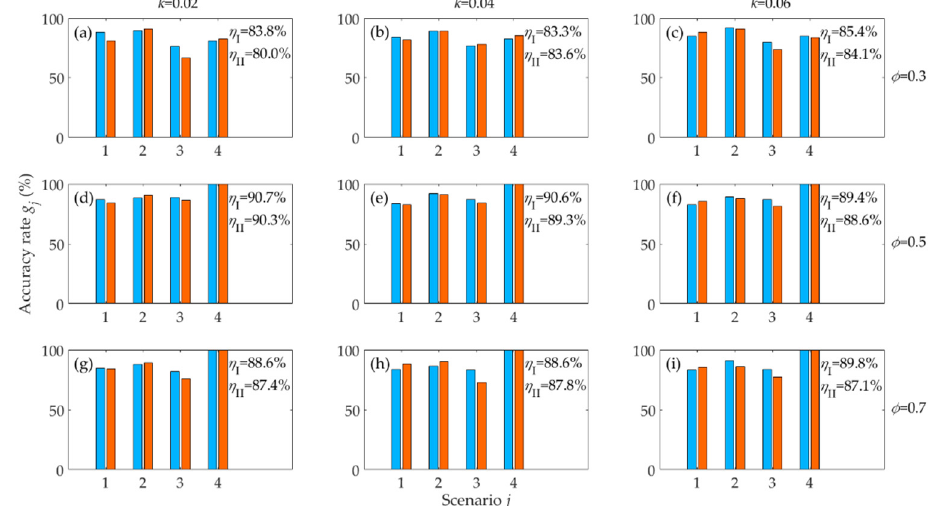
Figure 9. Accurate rates of trend tests by the MMK test and OW operation in simulation experiment 2 at the 5% significance level. (Note: the length of STS is 100; k and ϕ are the trend slope and the autoregressive coefficient in simulation experiment 2; Ⅰ and Ⅱ represent the results of the MMK test and OW operation, respectively; and the explanation for sub-figures ( a )–( i ) can be referred to Figure 7.)